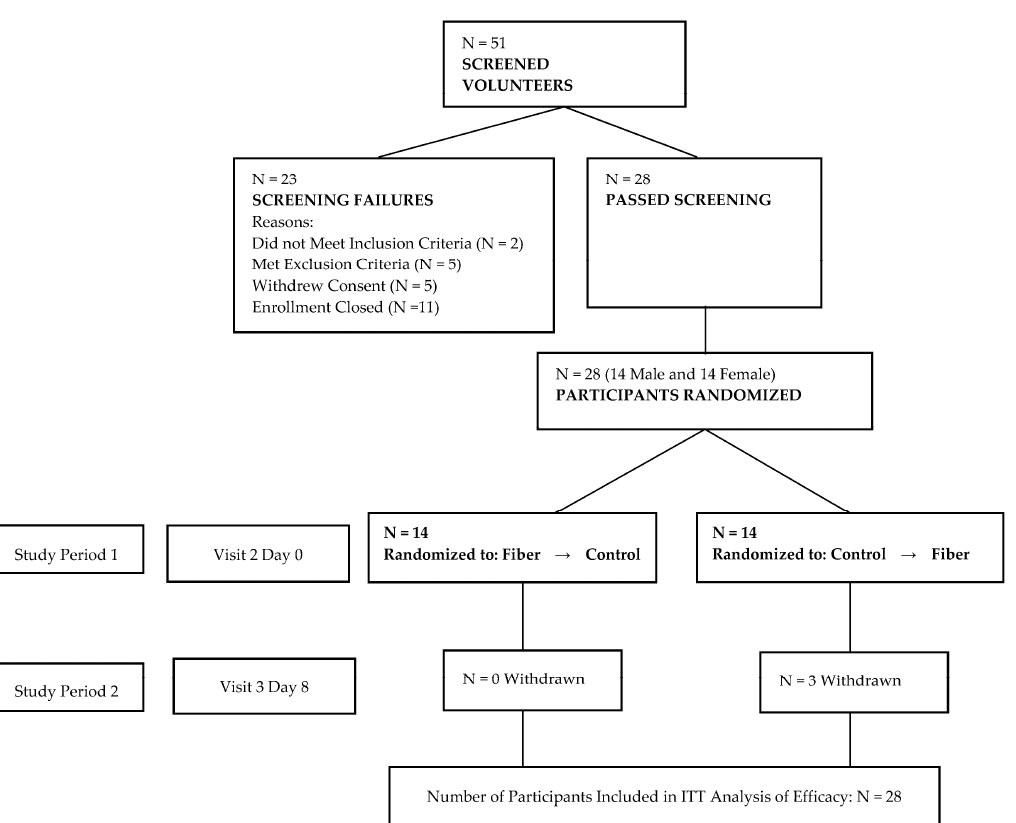
Figure 1. Subject flow through study.